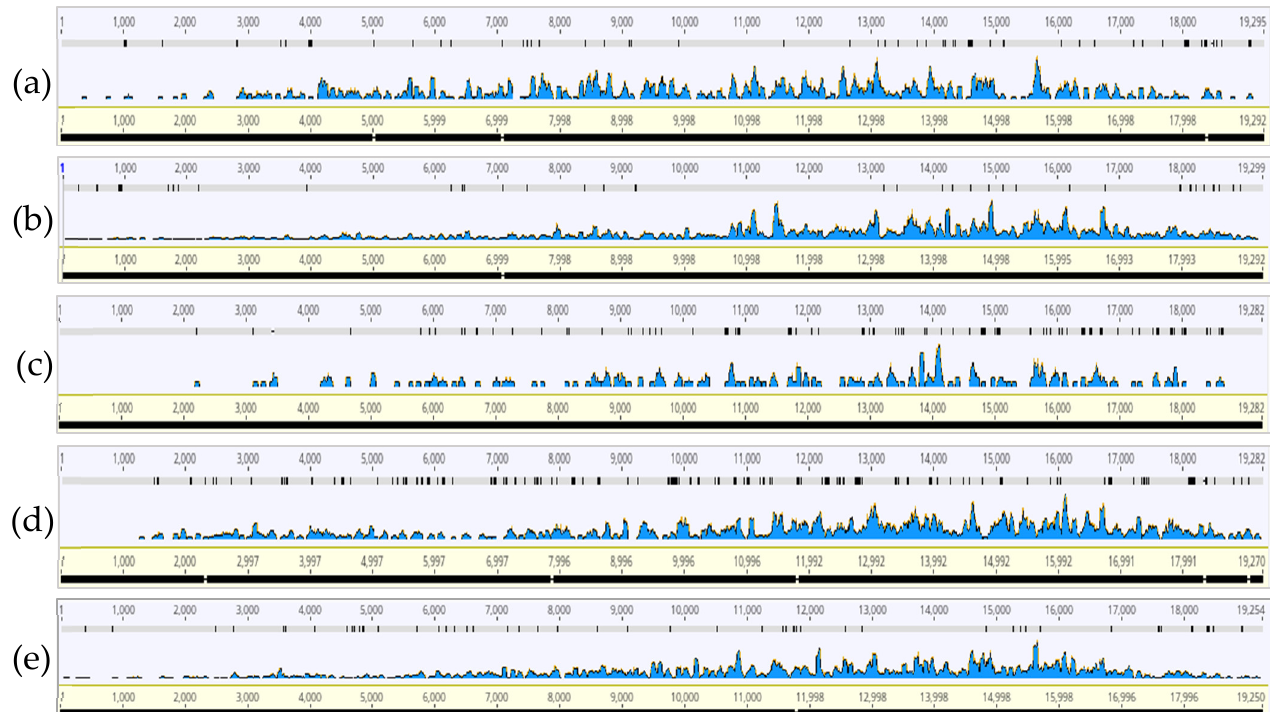
Figure 1. Read coverage and distribution profile generated from each Florida Region of 2019 aligned to the respective citrus tristeza virus (CTV). ( a ) Region A (CTV T36, KC517485.1); ( b ) Region B (CTV T36, KC517485.1); ( c ) Region C (CTV T36, KC517488.1); ( d ) Region D (CTV RB, KU358530.1); ( e ) Region E (CTV VT, KC748392.1).